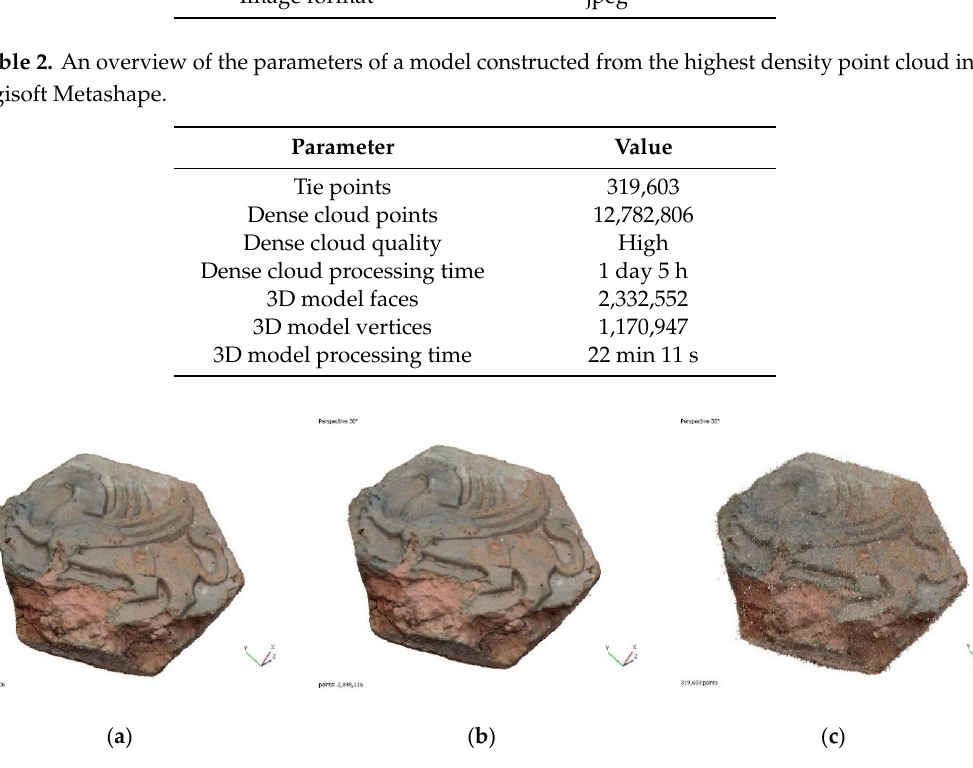
Figure 7. The dense cloud representations of the tile processed in Agisoft Metashape at different levels of detail (LODs): ( a ) 12,782,806 points ( b ) 2,848,116 points, and ( c ) 319,603 points.